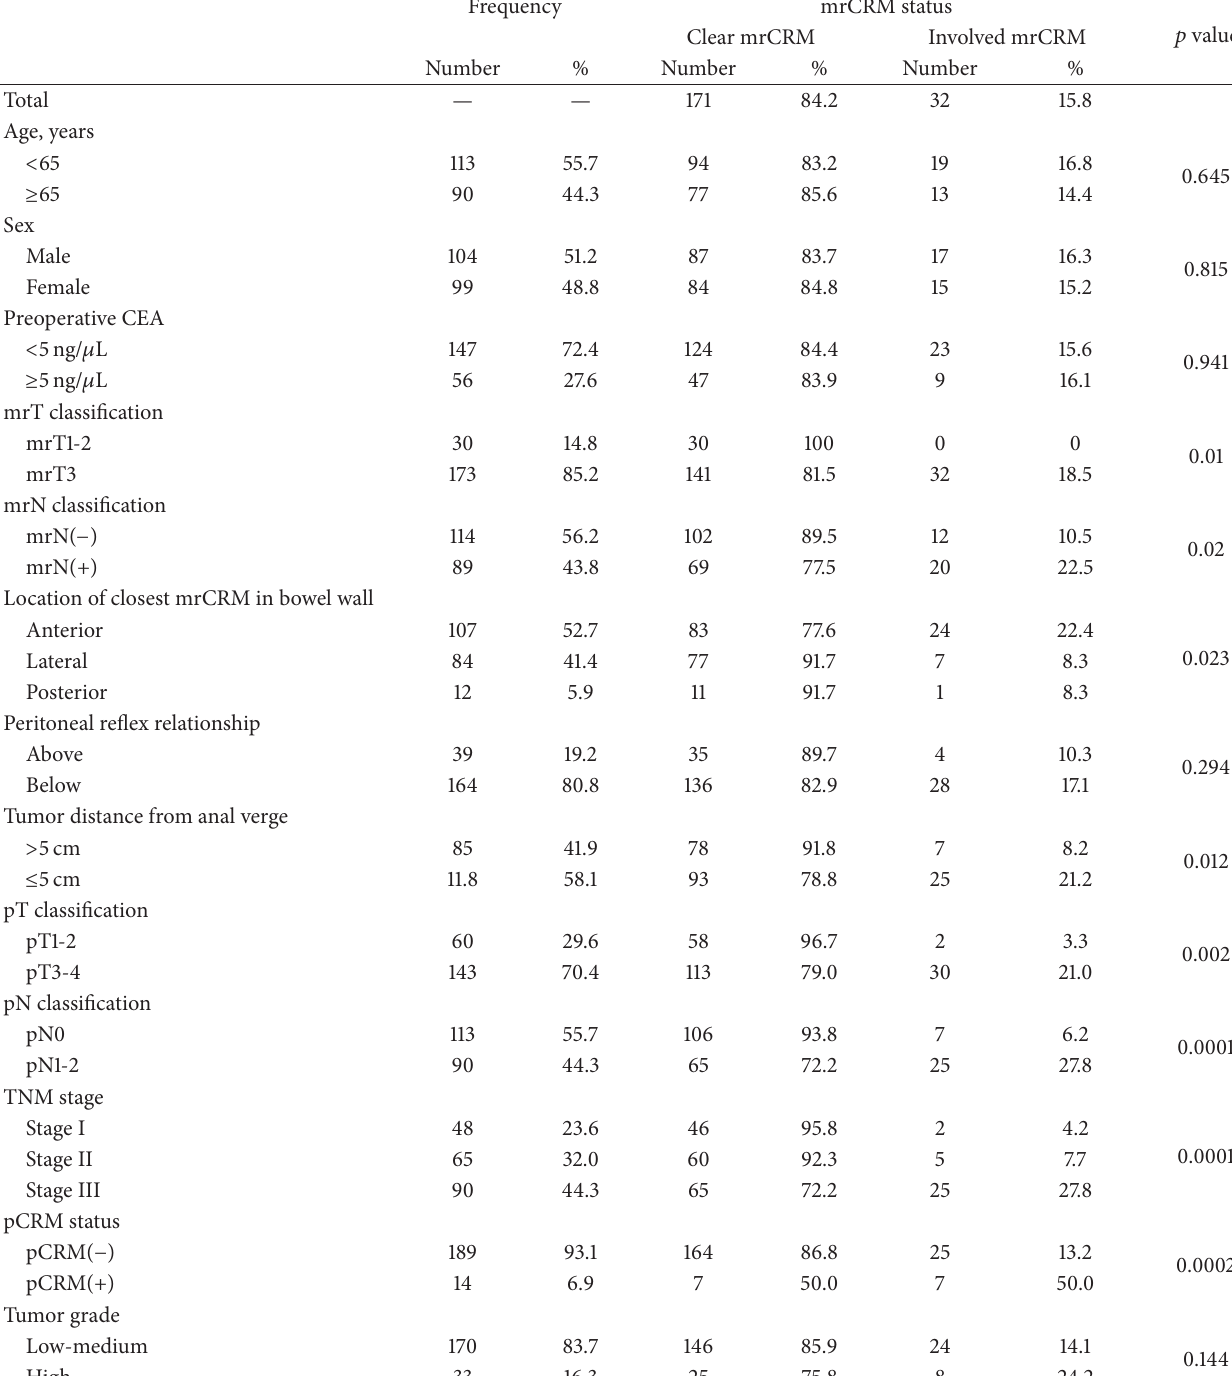
Table 1: The relationship between mrCRM status and clinicopathological